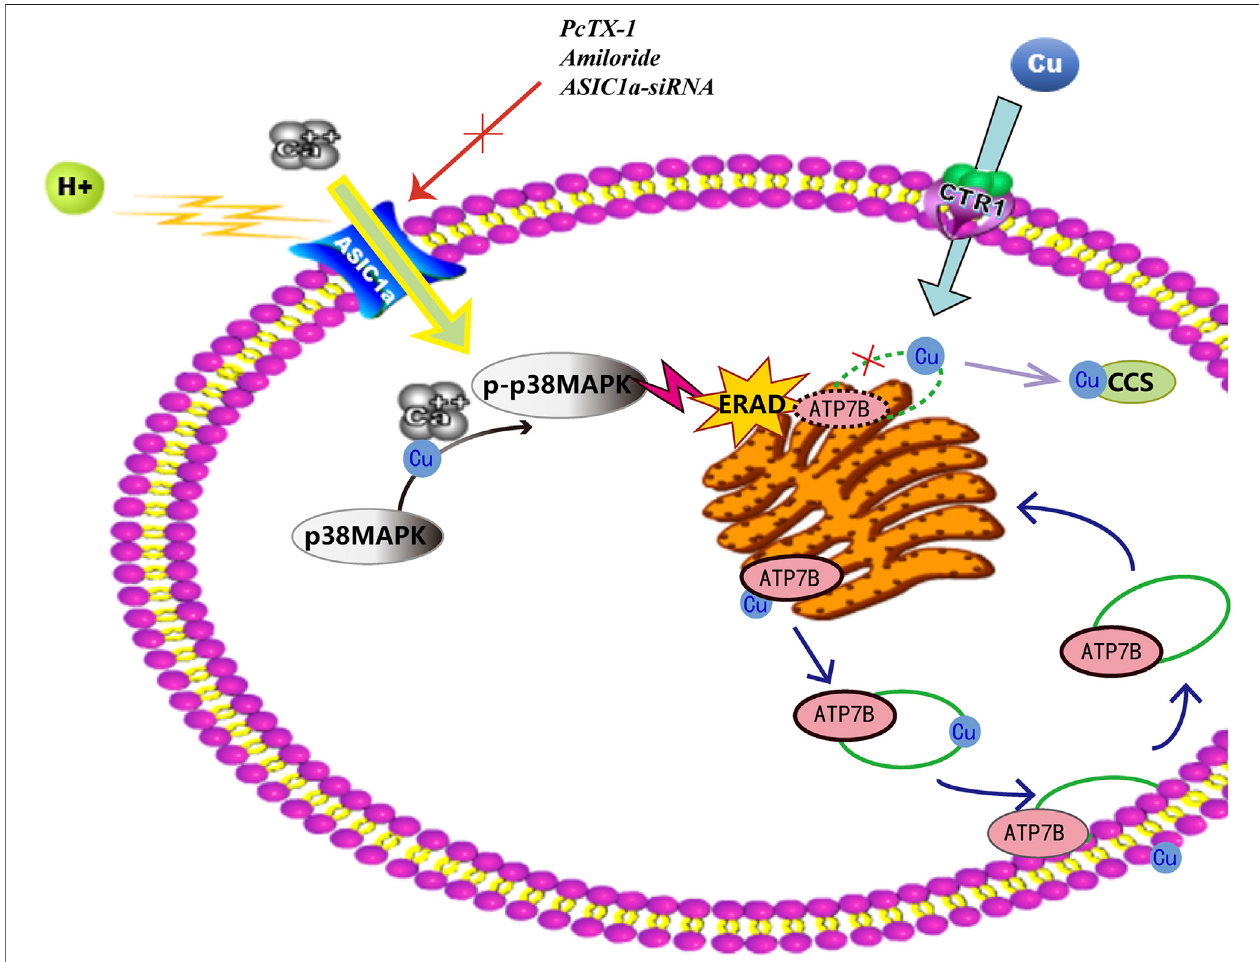
FIGURE 9 | Endoplasmic reticulum stress mediated by ASIC1a through the P38 MAPK signalling pathway contributes to the activation of HSCs and the degradation of ATP7B induced by copper.